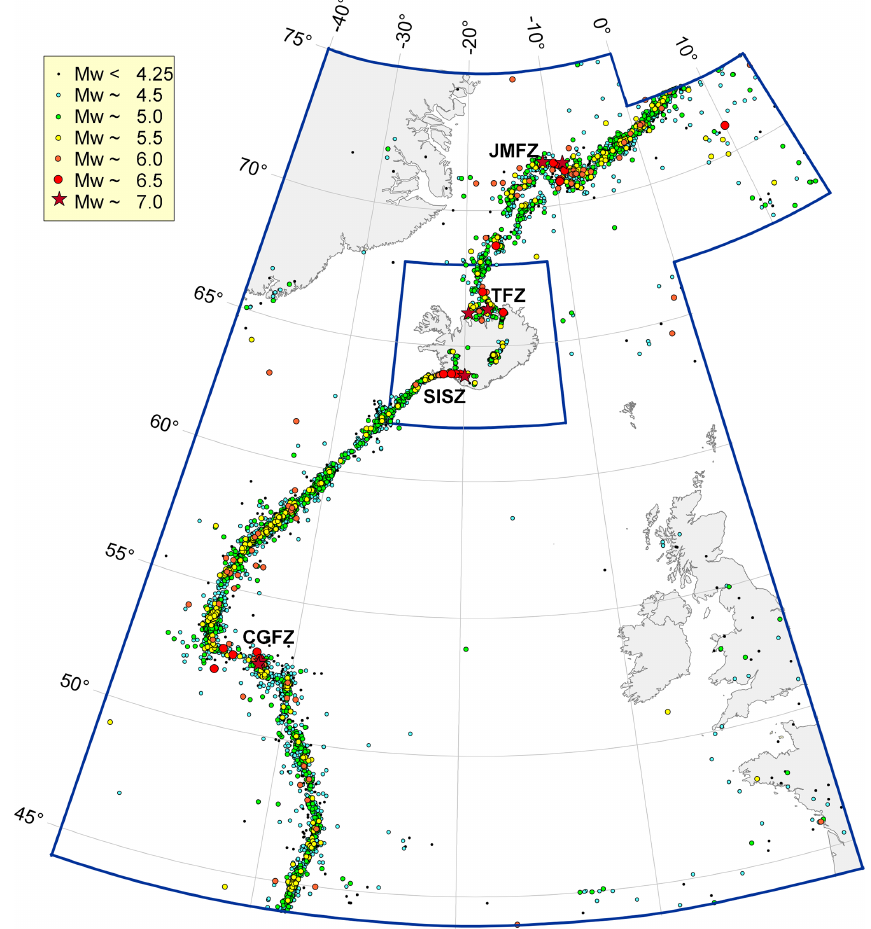
Figure 2. The NMAR region, 44–75 ◦ N, 0–40 ◦ W, and 67–73 ◦ N, 0–17 ◦ E. The small part in the Eastern Hemisphere is added to make the region include all of the AOI region of Grünthal and Wahlström (2012). The ICEL region is also marked. Four main seismic zones are marked on the map, i.e. the Charlie-Gibbs Seismic Zone (CGSZ), South Iceland Seismic Zone (SISZ), Tjörnes Fracture Zone (TFZ), and Jan Mayen Fracture Zone (JMFZ). The displayed locations and magnitudes are those of the new